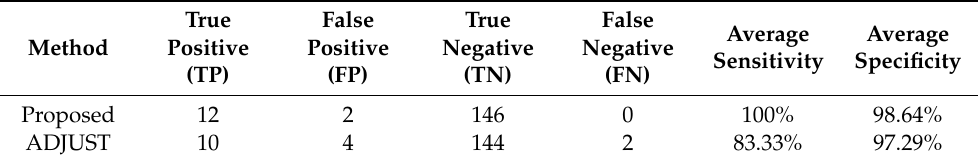
Table 5. Performance evaluation of the proposed algorithm and ADJUST for all